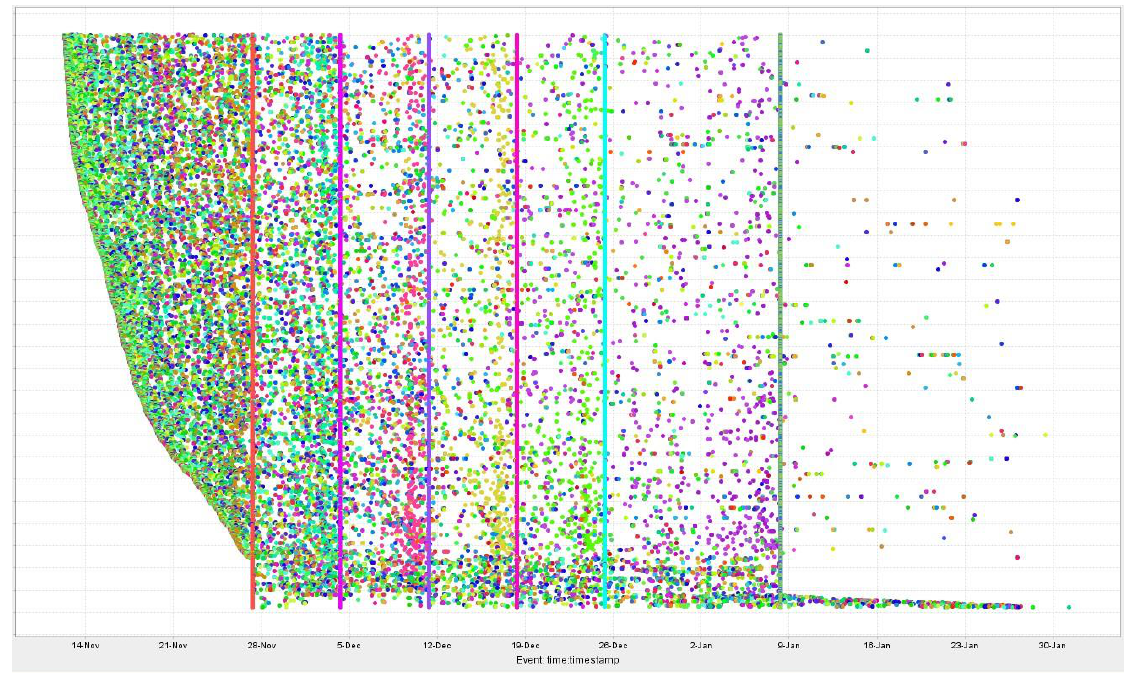
Figure 8. Video watching trends for cluster